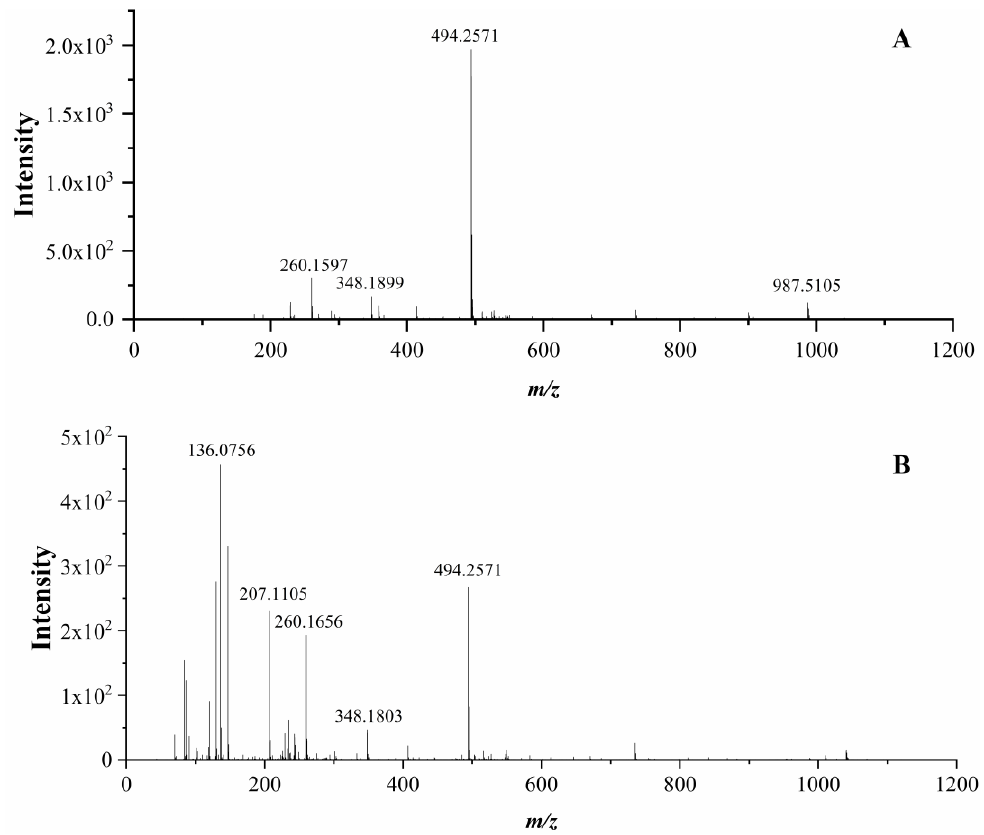
Figure 5. Mass spectrometry (MS) spectra of peak at 14.08 min by full scan-survey mode. Key: ( A ), at low collision energy (6 eV); ( B ), at high collision energy (20 eV).